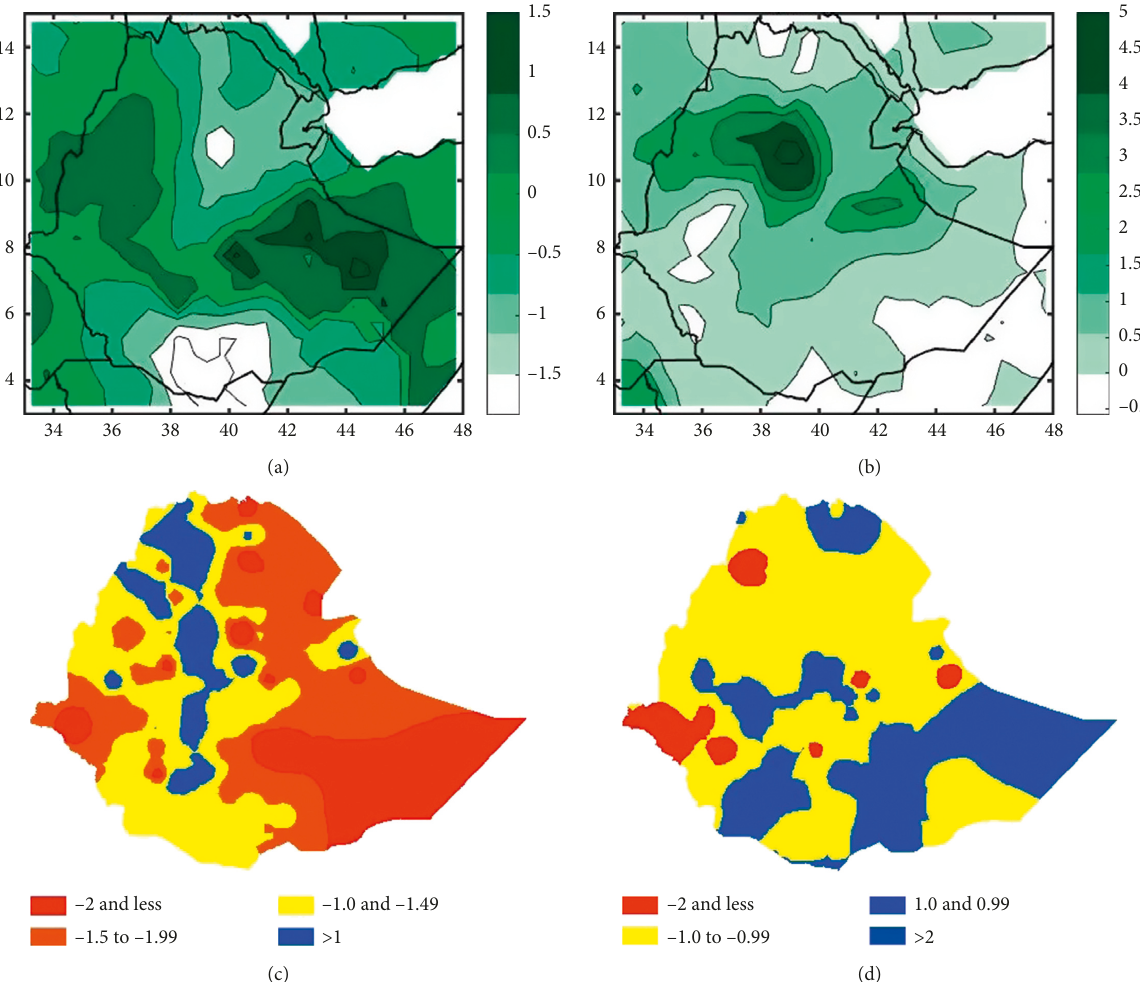
Figure 2: Contour-based spatial rainfall variability of (a) FMAM and (b) JJAS seasons. Standardized rainfall anomaly of (c) FMAM and (d) JJAS seasons.